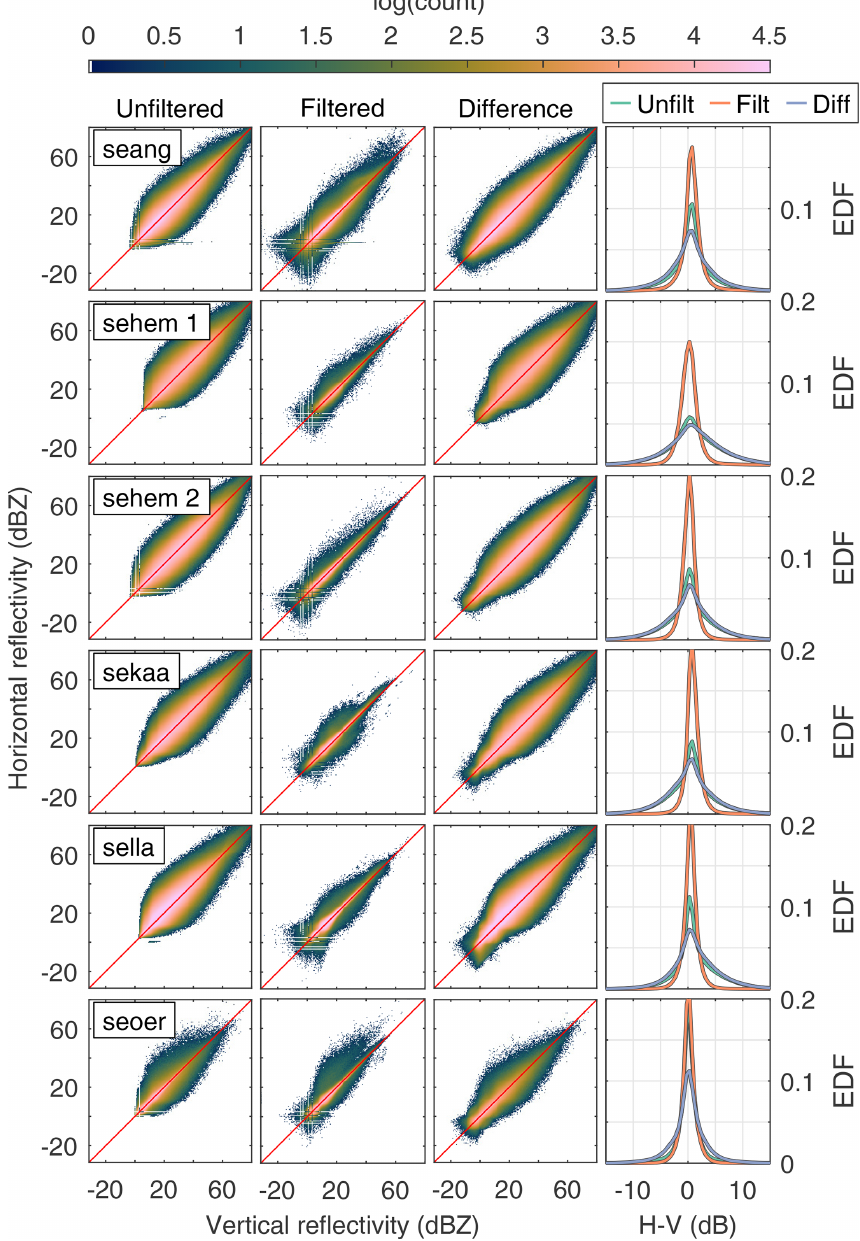
Figure 10. Columns 1–3 show histograms of pairwise measurements of reflectivity data using horizontal and vertical polarization for three different data sets: unfiltered reflectivity, Doppler-filtered reflectivity, and the difference between the unfiltered and filtered data sets. Col- umn 4 shows empirical distribution functions of the pairwise difference between horizontal and vertical